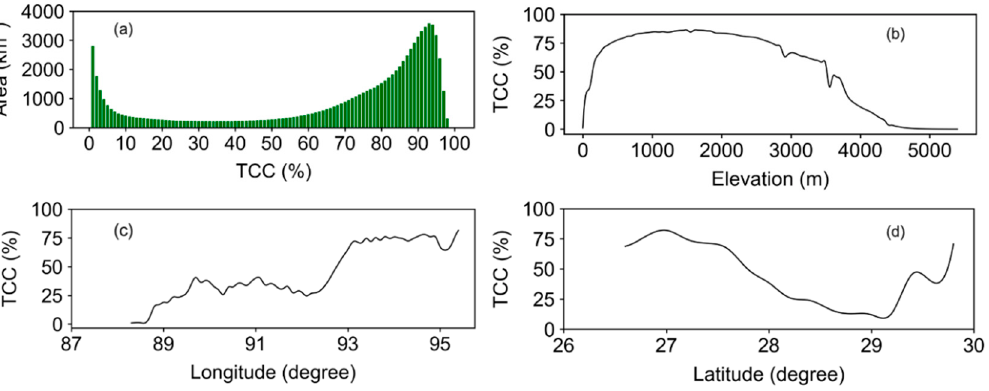
Figure 6. ( a ) Area distribution of the mean TCC between 1990 and 2020 for each percent TCC range with 1% increment, and distributions along elevation ( b ), longitude ( c ), and latitude ( d ) of the mean